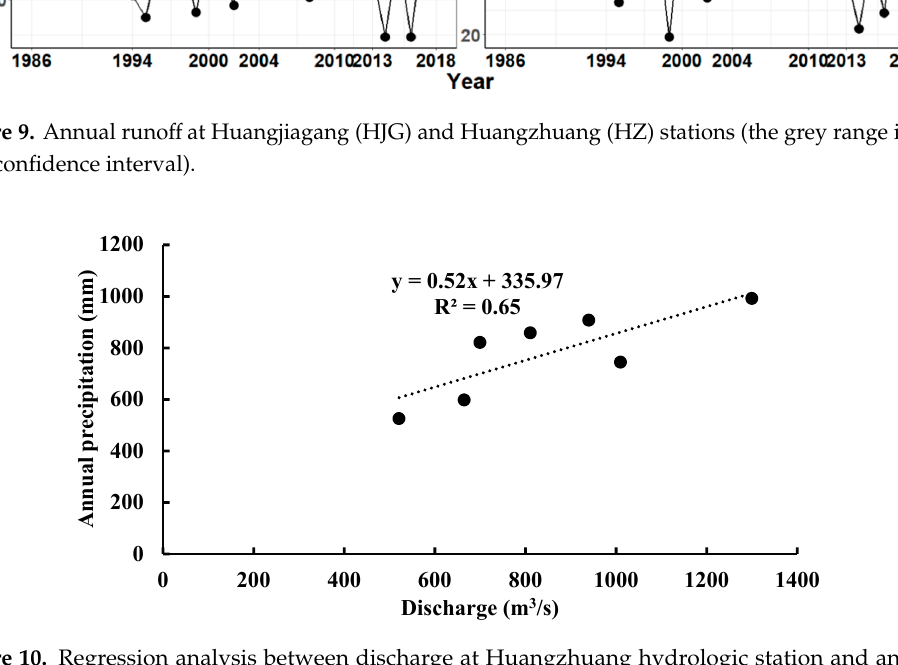
y = 0.52x + 335.97 R² = 0.65